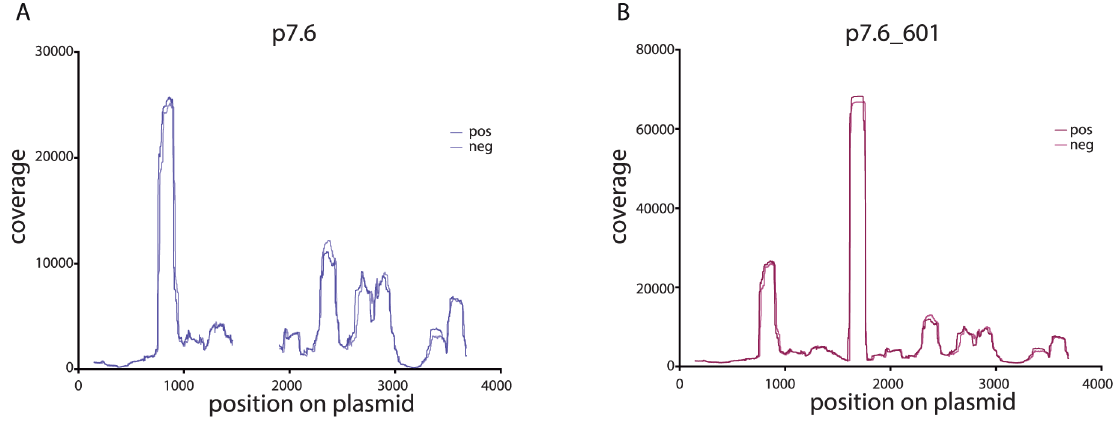
Figure 7. The 601 nucleosome-positioning sequence positions a plurality of invitrosomes. 7A Coverage plot for the se`t-group plasmid p7.6 with both forward (pos) and reverse (neg) invitrosomes plotted separately on the same graph. 7B Coverage plot for plasmid p7.6_601 which harbors the 601 nucleosome-positioning sequence with both forward (pos) and reverse (neg) invitrosomes plotted separately on the same graph. The highest peak starting at about base pair 1600 is where the 601 sequence begins.